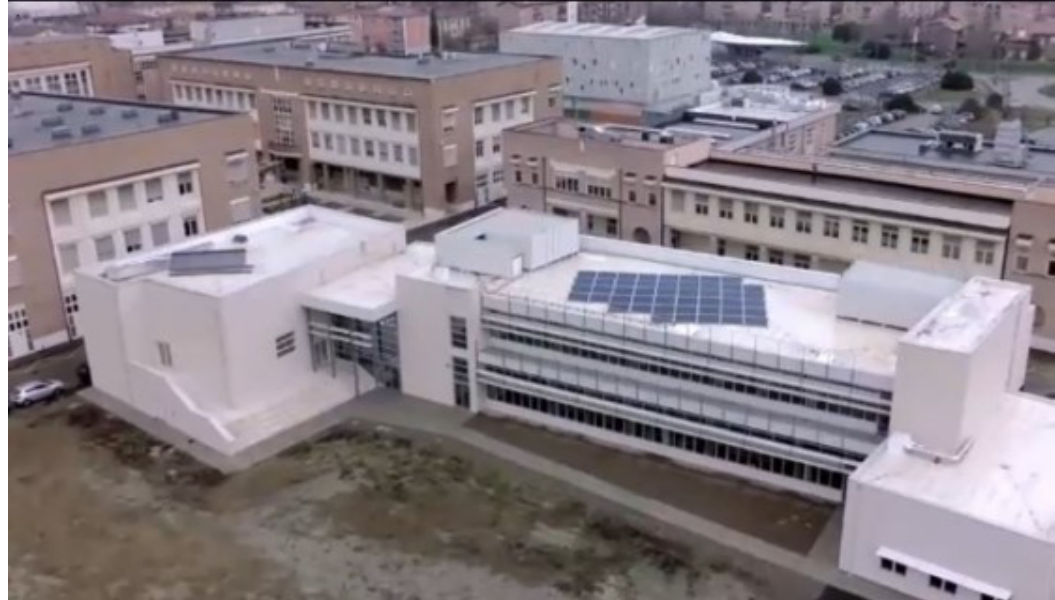
Figure 1. Flatroof with cool white waterproofing membrane (Tecnopolo building of the University of Modena and Reggio Emilia, Modena,